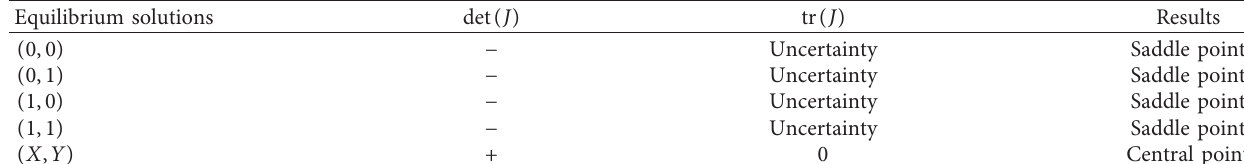
Table 2: Evolutionary stability analysis based on the Jacobian matrix.